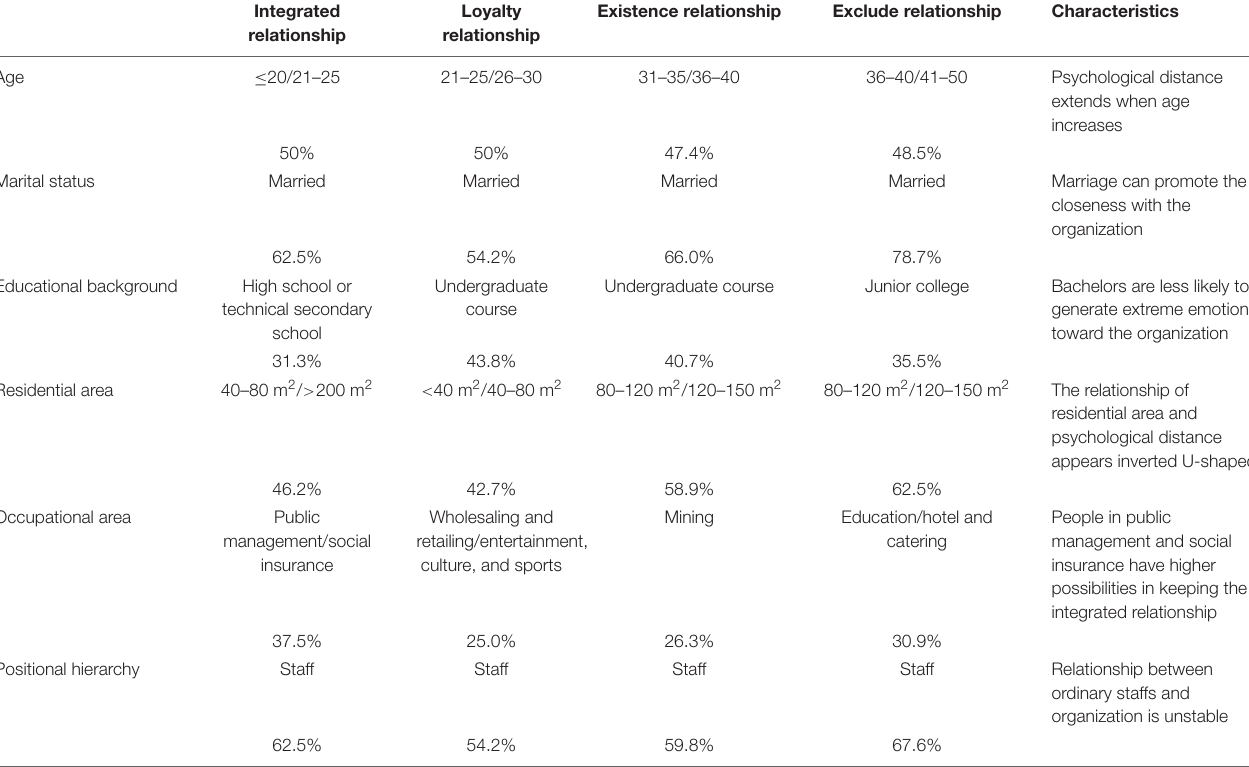
TABLE 5 | Social statistic characteristics of four relationships ( N = 554).